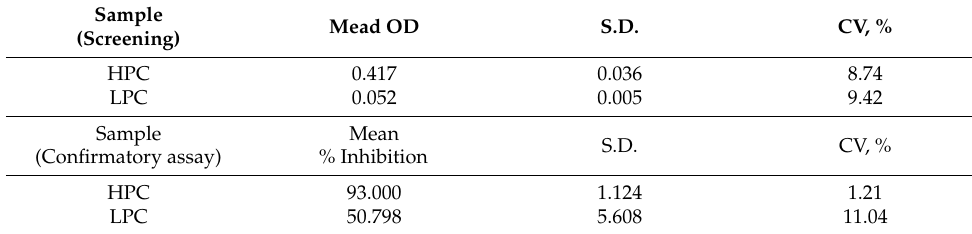
Table 10. Inter-day precision results.